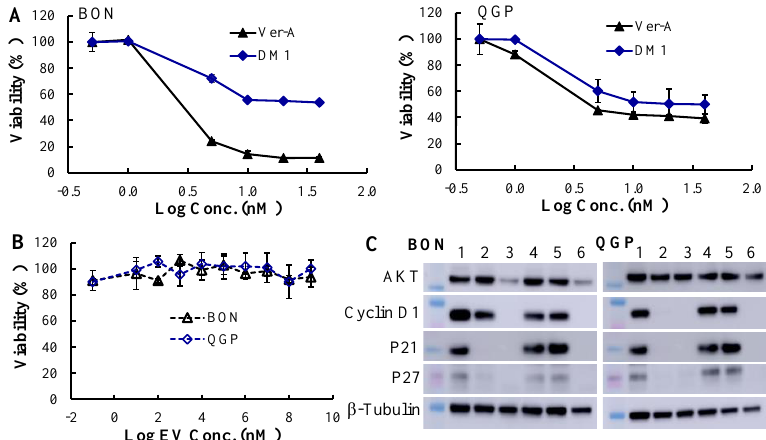
Figure 3. In vitro anticancer evaluation. ( A ) The anticancer cytotoxicity IC 50 of free drug Ver-A ( ♦ ) and DM1 ( ▲ ) in BON and QGP cells (data represent mean ± SEM, n = 3). ( B ) No cytotoxicity of empty EV was detected. ( C ) Western blotting analysis of proliferation and apoptosis biomarkers in BON and QGP. 1: PBS control; 2: 5 nM Ver-A; 3: 10 nM Ver-A; 4: 10 nM DM1; 5: 20 nM DM1; and 6: 5 nM EV- Ver-A/DM1.